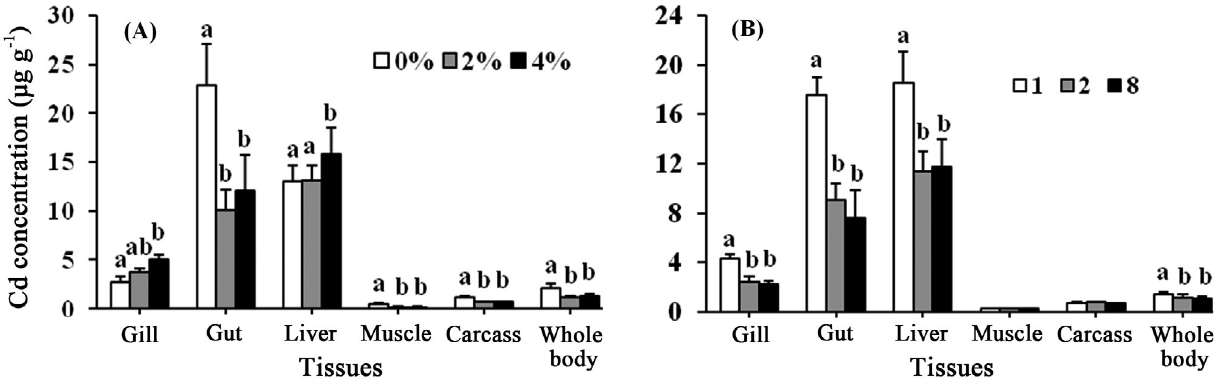
Fig. 1. Cadmium concentration (µg Cd g –1 in dry matter) in the gills, gut, liver, muscle, carcass and whole body of black sea bream Acanthopagrus schlegeli exposed to waterborne Cd (97.2 µg l –1 ) for 5 wk at 3 different levels of feeding ratio (FR) or frequency (FF). (A) FR treatment: fish were fed 0, 2 and 4% body weight d –1 at 2 times d –1 . (B) FF treatment: fish were fed 1, 2 and 8 times d –1 at a feeding ratio of 3% body weight d –1 . Mean ± SD, n = 6 (3 fish per replicate tank); means of the same tissue with different superscripts are significantly different among treatments (p <